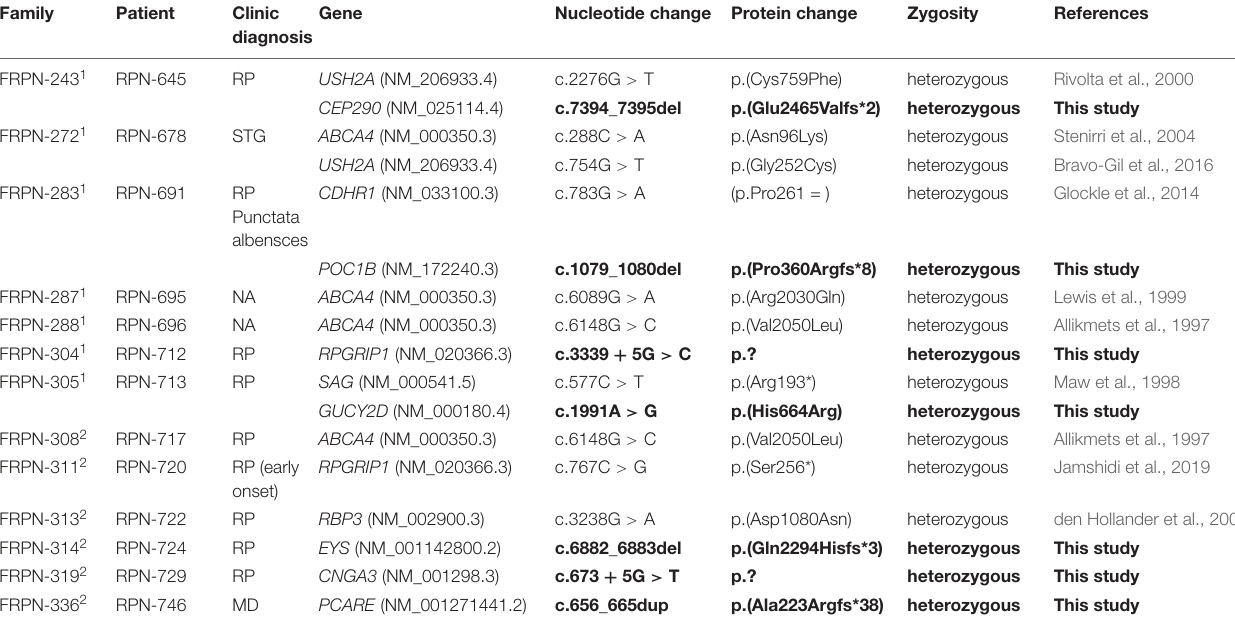
TABLE 2 | Patients in which only one pathogenic variant in a recessive gene has been identified.